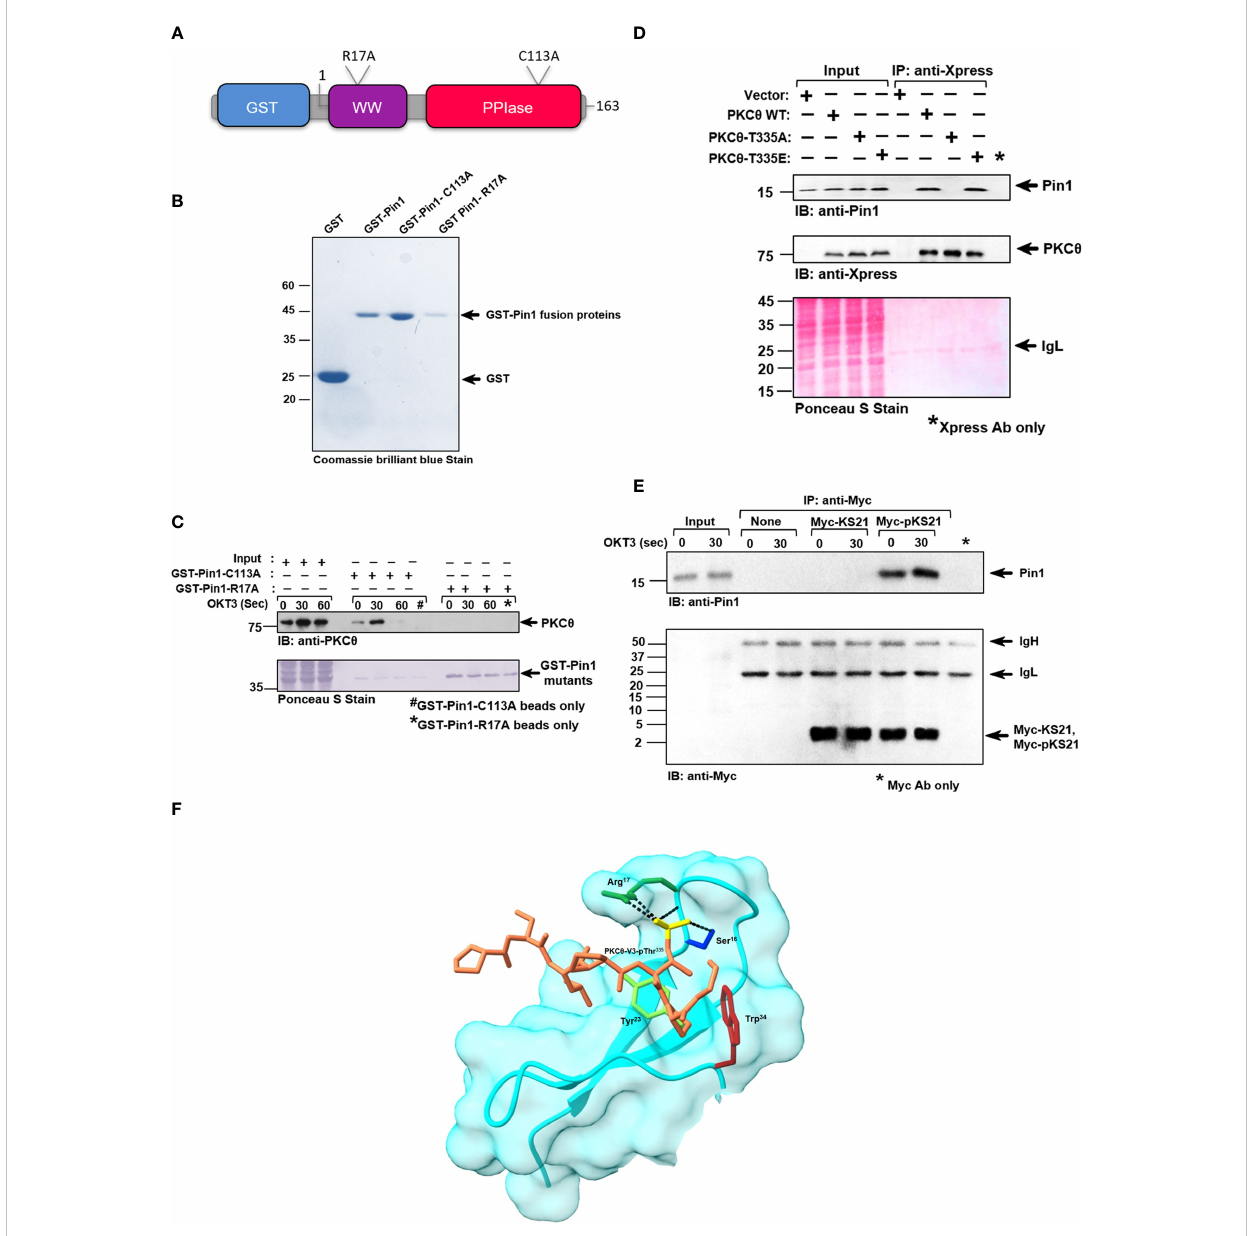
FIGURE 3 Pin1-PKC q association is mediated by the N-terminal WW domain of Pin1 and the pThr 335 -Pro motif in PKC q . (A) Schematic representation of GST- tagged point mutants of Pin1 utilized for this study, as indicated. The position and nature of the amino acid substitutions are indicated. (B) Coomassie brilliant blue stain of DH5 a -expressed, puri fi ed GST-tagged wildtype and point mutants of Pin1 protein, utilized in this study. (C) Jurkat TAg cells were stimulated with anti-CD3 mAb (OKT3) at the indicated intervals and cell lysates were subjected to a pull-down assay using GST-Pin1- R 17 A and GST-Pin1-C 113 A fusion proteins followed by immunoblot (IB), as indicated. (D) Immunoblot (IB) analysis of Xpress (PKC q ) immunoprecipitates from COS-7 cells transfected with an empty vector or the indicated Xpress-tagged PKC q vectors. Data are representative of three independent experiments. IgH, Ig heavy chain. (E) Myc-tagged peptides, KS21 and pKS21, which correspond to Thr335, in the PKC q -V3 domain, plus ten amino acids on either side of this sequence. KS21-Myc peptide lacks a phosphoryl group on Thr335 while pKS21-Myc, consists of an additional phosphoryl group on the Thr335 motif. Peptides (5 m g/sample) were conjugated with protein A-agarose bead-immobilized anti-Myc Abs. Jurkat TAg cells were left unstimulated or stimulated for 30 sec with anti-CD3 mAb (OKT3). Myc-KS21 and Myc-pKS21 were then immunoprecipitated (IP) from the cell lysates using anti-Myc mAbs. Whole-cell lysates (Input) and immunoprecipitates were subjected to PAGE on 16.5% Tris-tricine gel followed by sequential immunoblot (IB) with anti-Pin1 and anti-Myc Abs. Data are representative of three independent experiments. Molecular weight markers (in kDa) are indicated on the left and arrow mark positions of the indicated protein bands. IgH, Ig heavy chain. (F) A model of the PKC q -Pin1 complex, provides a structural interpretation of some key experimental observations. The surface and